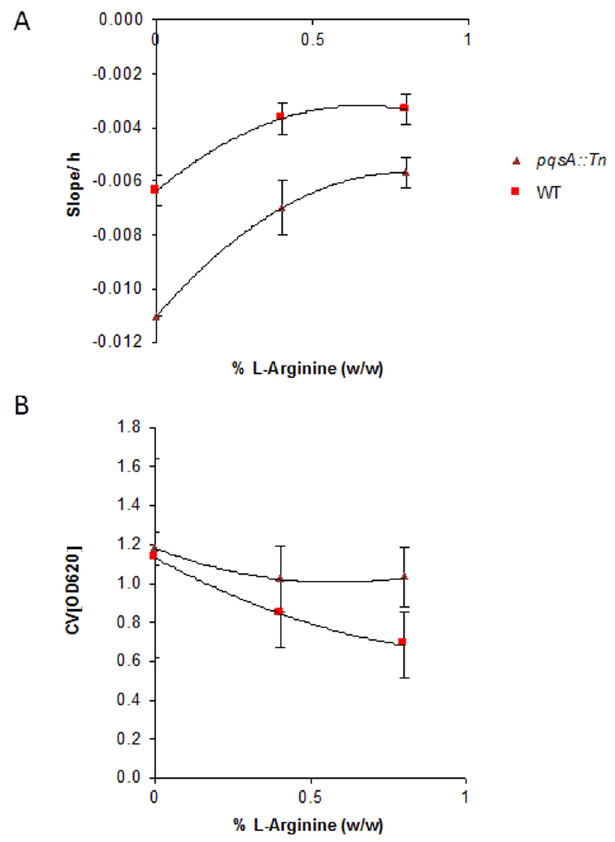
Figure 4. Impact of L-arginine (n = 3) ( A ) on the cell index slope measured by single-frequency impedance spectroscopy over 41 h and ( B ) on the crystal violet staining intensity of PA14 wt and the pqsA::Tn mutant strains. The crystal violet background of the medium was subtracted. n indicates the number of technical